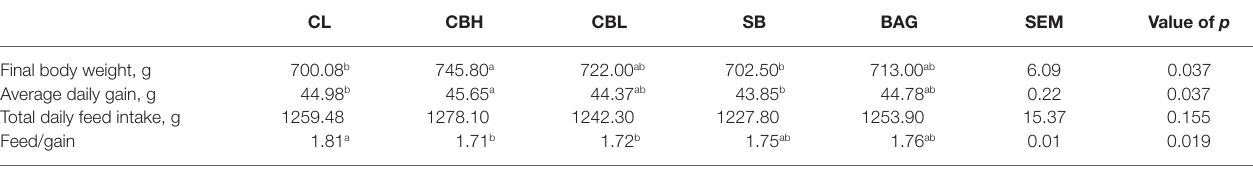
TABLE 10 | Offspring performance of yellow-feathered breeder hens. CL CBH CBL SB BAG SEM Value of